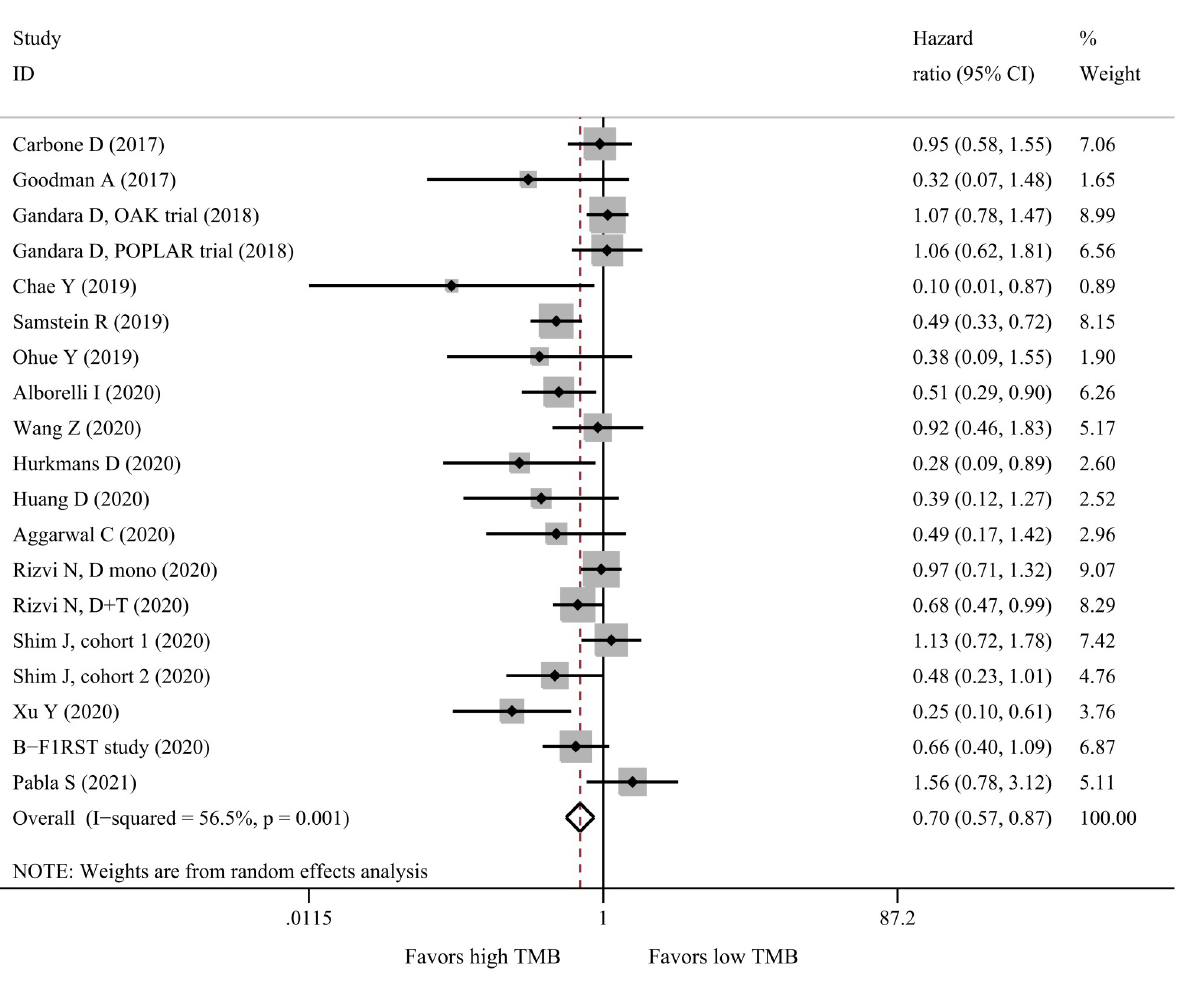
Fig 3. Forest plot for OS of high-TMB versus low-TMB in NSCLC patients receiving immunotherapy. OS: Overall survival; TMB: Tumor mutational burden; NSCLC: Non-small cell lung cancer.